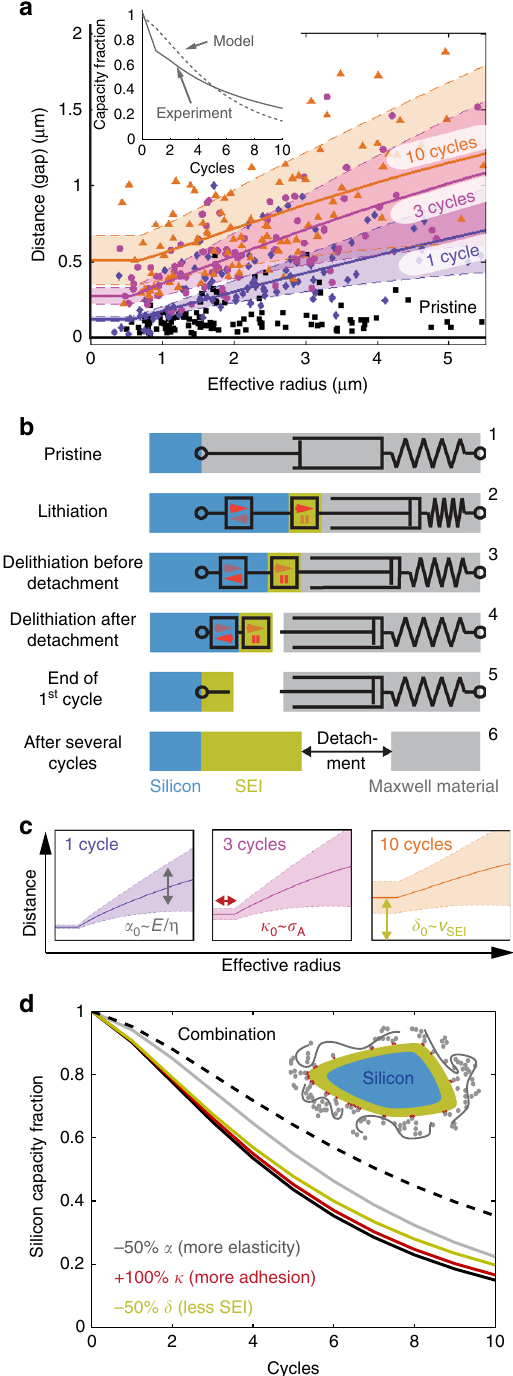
Fig. 4 Quantitative analysis. a Transmission X-ray tomographic microscopy data from Fig. 2b superimposed with additional data obtained from stereographic conversion of the 2D scanning electron microscopy data presented in Fig. 3 for pristine electrodes (black square), and electrodes cycled once (purple diamonds), three times (magenta circles), and ten times (orange triangles). The colored solid lines and shaded regions show the distance expectation values and corresponding standard deviations according to the model presented in the main text. The inset compares the silicon capacity retention of the experimental data (solid line) with the simulation of the model (dashed line). b Sketch of the fundamental components of the model and operation at various stages in the electrochemical cycling process. Silicon expansion and contraction, as well as solid electrolyte interphase (SEI) growth are represented by linear actuators, while the carbon black-binder domain and the electrode material in the direct vicinity of a silicon particle are represented as Maxwell material that consists of a spring element with a damper element in series. and δ 0 / v that c Illustrations of the three parameters α 0 / E = η , κ 0 / σ A SEI affect different parts of the model. d Simulation of silicon capacity retention for different fi ctive parameter con fi gurations, gray line: − 50% α (more elasticity), red line: + 100% κ (more adhesion), green line: − 50% δ (less solid electrolyte